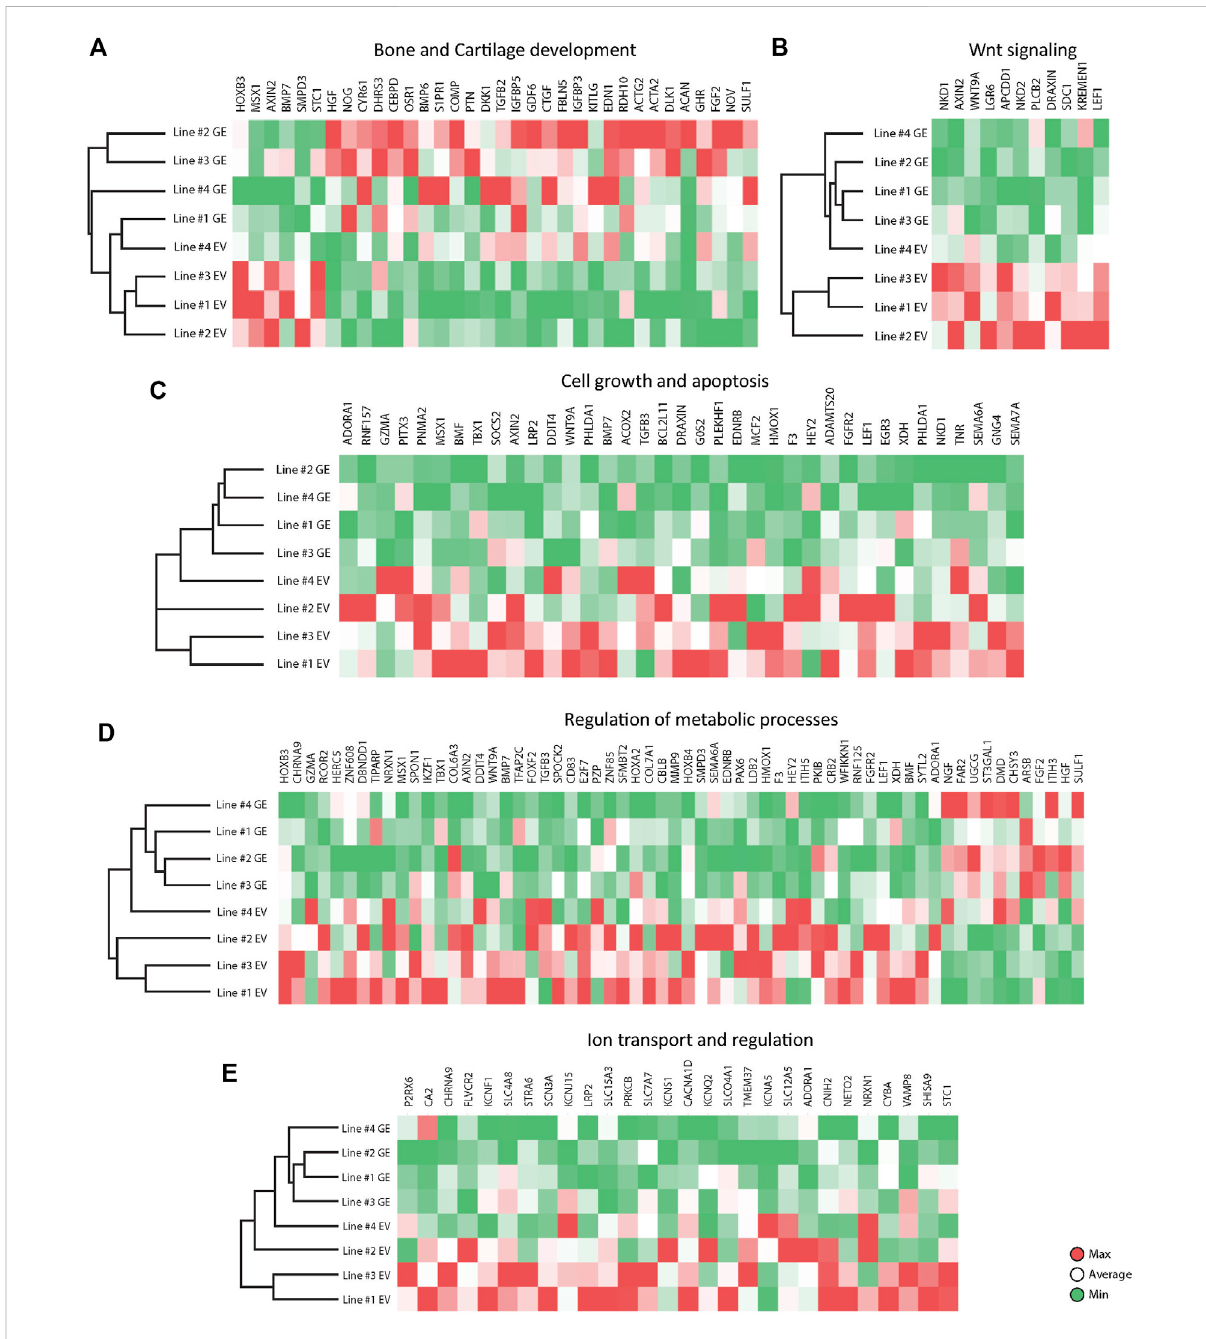
FIGURE 6 Expression analysis of differentially expressed genes between GE and EV. Expression analysis of differentially expressed genes involved in (A) Bone and Cartilage development, (B) WNT signaling, (C) Cell growth and apoptosis, (D) Metabolic processes, (E) Ion transport and regulation. GE: Gene edited with ARSB cDNA, EV: Gene edited with empty vector